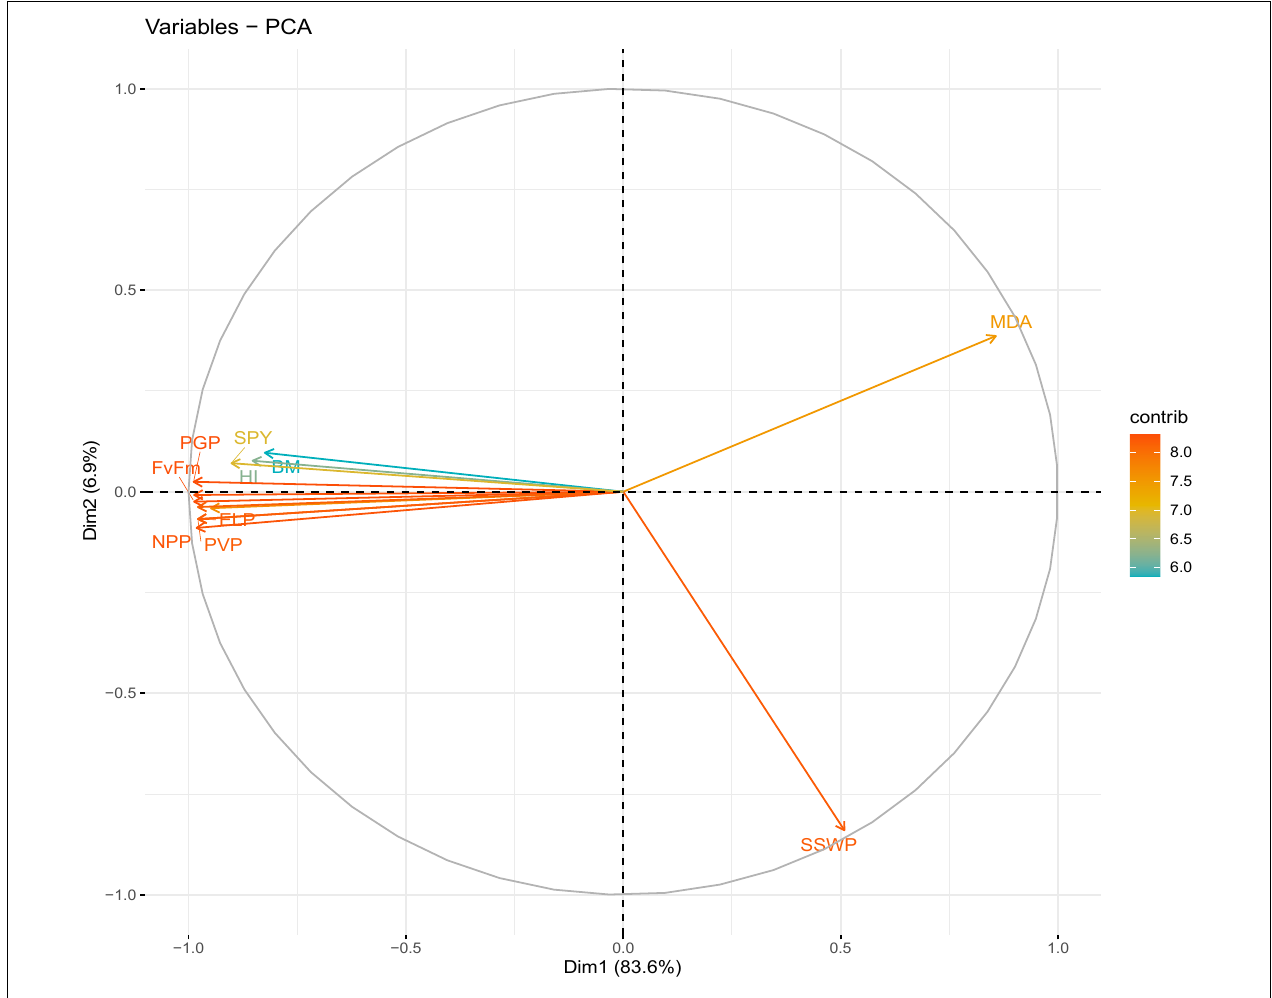
FIGURE 7 | Principal component analysis (PCA) of various traits in chickpea genotypes under heat stress in a growth chamber.